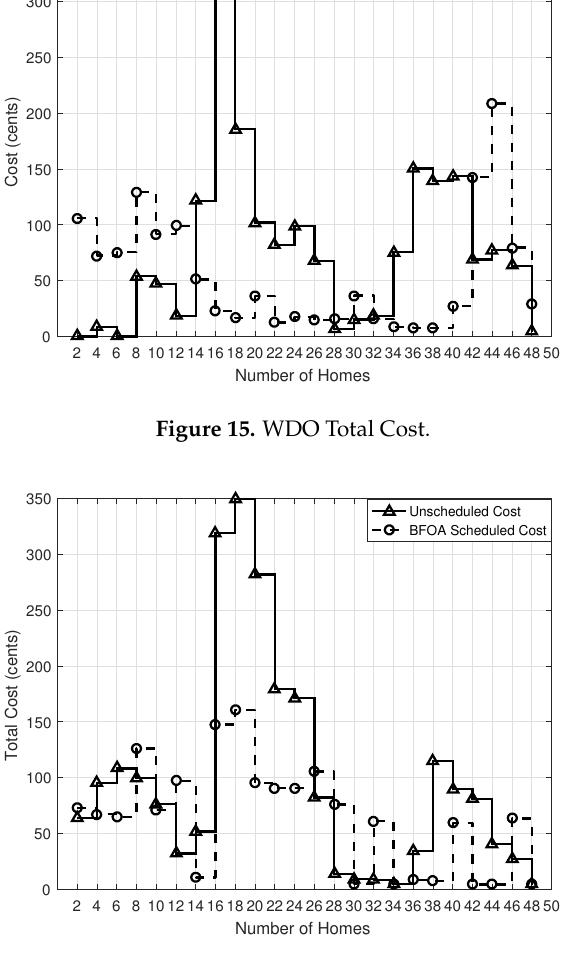
Figure 16. BFOA total